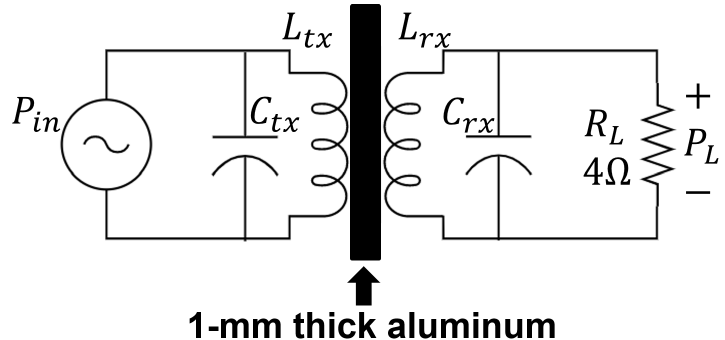
Figure 4. Circuit used to measure harvested power for the designed coil.